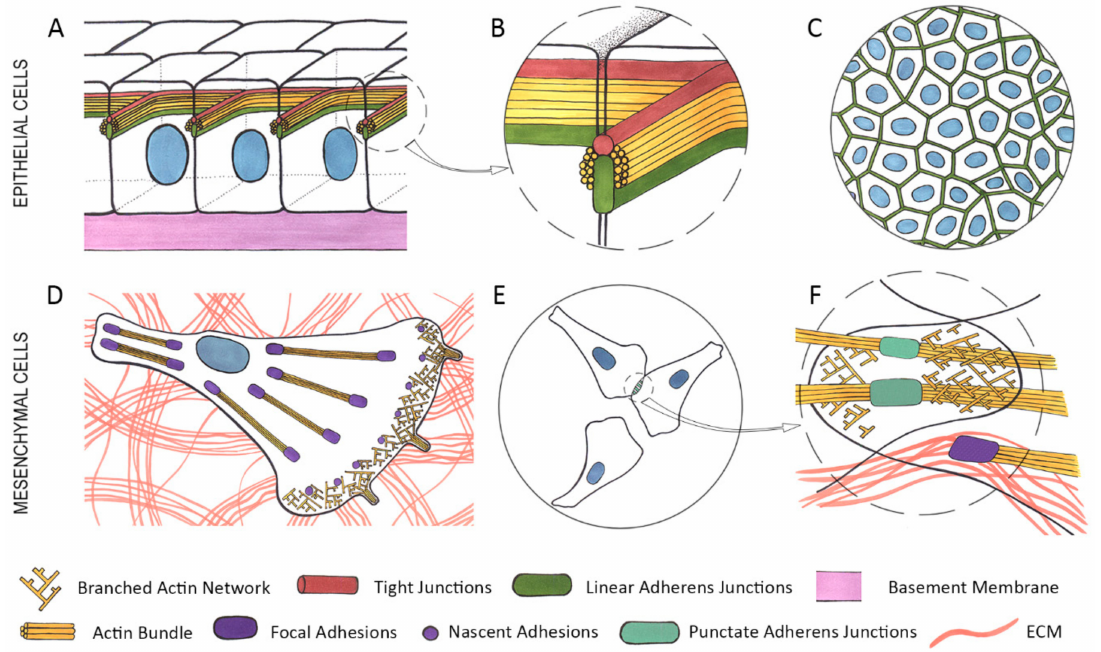
Figure 1. Organization of the actin cytoskeleton and adhesive structures in epithelial and mesenchymal cells. ( A )—a monolayer of epithelial cells. ( B )—a close-up of an area in the dashed circle on A—stable cell-cell adhesion in epithelial cells is provided by apical adhesion belts comprised by tight junctions (TJs) (red) and linear adherens junctions (AJs) (green), both of which are closely associated with the circumferential actin bundle (yellow). ( C )—a top view of a monolayer of epithelial cells, connected by stable linear AJs. ( D )—a mesenchymal cell exhibiting branched actin network (yellow) and nascent focal adhesions (FAs) (purple) in lamellipodia at the leading edge. Closer to the center of the cell and in the rear are mature FAs (purple) associated with straight actin bindles (yellow). Both nascent and mature FAs are connected to the extracellular matrix (ECM) (pink). ( E )—an area of cell-cell interaction between motile mesenchymal cells. ( F )—a close-up of the area in the dashed circle on E—overlapping lamellae containing branched actin network (yellow) point to the lack of contact paralysis, unstable punctate AJs (green) are associated with straight actin bundles. Mature FAs (purple) connected to the ECM (pink) are associated with straight actin